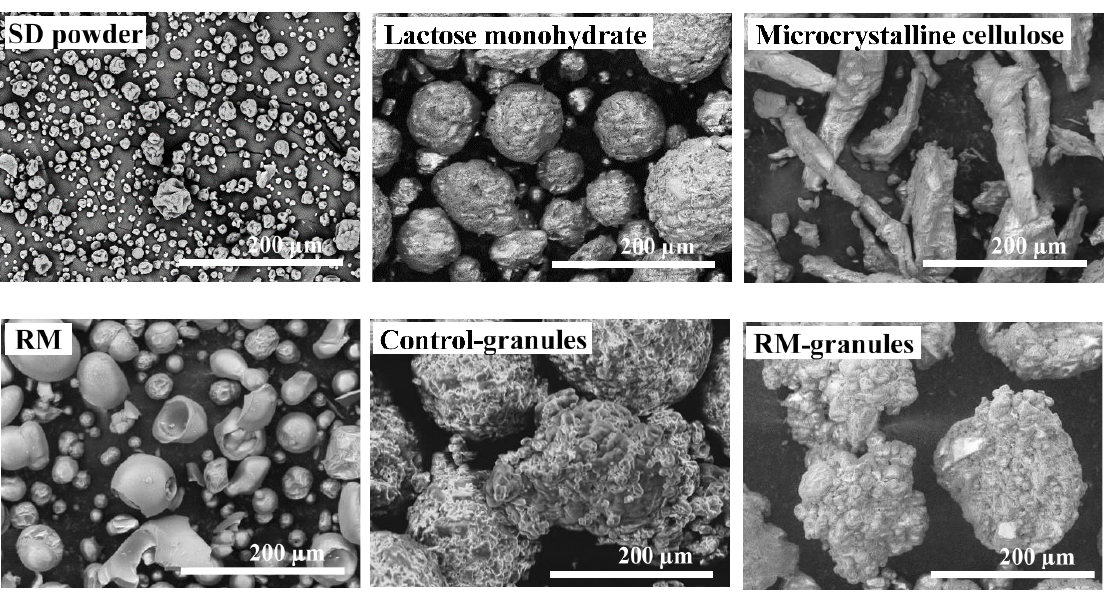
Figure 4. SEM images of SD powder, lactose monohydrate, microcrystalline cellulose, resistant maltodextrin (RM), Control-granules, and RM-granules.